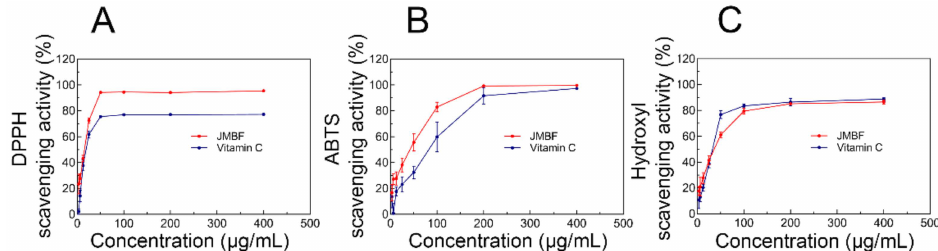
Figure 8. In vitro antioxidant capacity of flavonoids derived from J. mandshurica . ( A ) DPPH- scavenging activity of JMBF. ( B ) ABST radical-scavenging activity of JMBF. ( C ) Hydroxyl radical- scavenging activity of